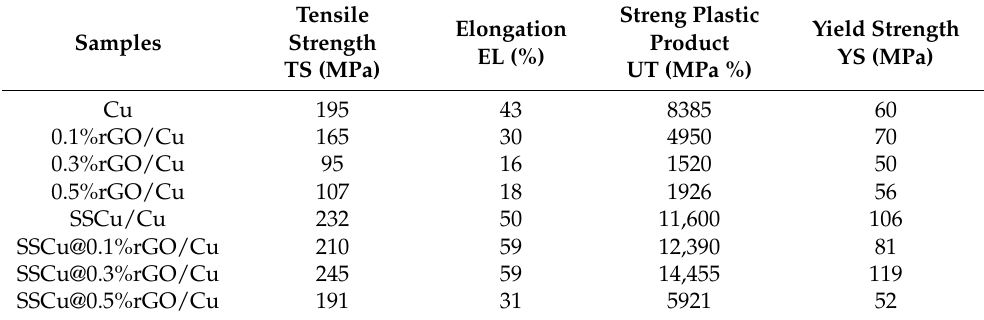
Figure 8. ( a ) Comparison of the UT and EC values of the SSCu@rGO/Cu composites prepared in